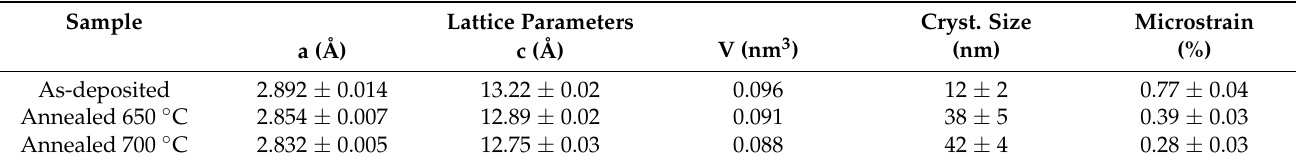
Table 2. The lattice parameters, the mean crystallite size, unit cell volume and the microstrain of the Cr 2 AlC 211 MAX phase, as revealed by the MAUD fitting of the diffractograms of as-deposited and annealed films.